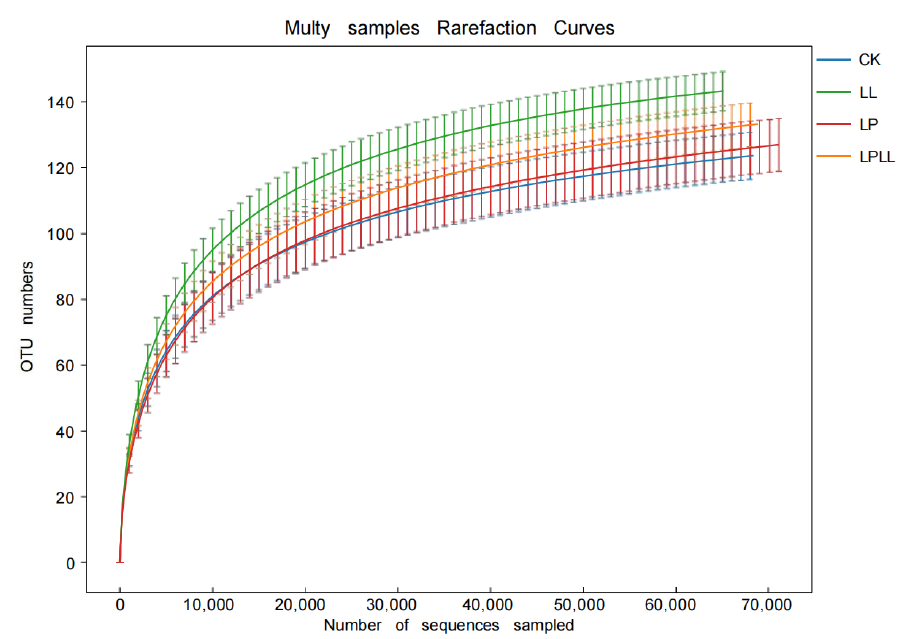
Figure 2. OTU curve of fermented sugarcane juice. CK: fresh sugarcane juice; LL: sugarcane juice with added HNK10; LP: sugarcane juice added with HNK21; LPLL: sugarcane juice treated with HNK10 + HNK21 was added.